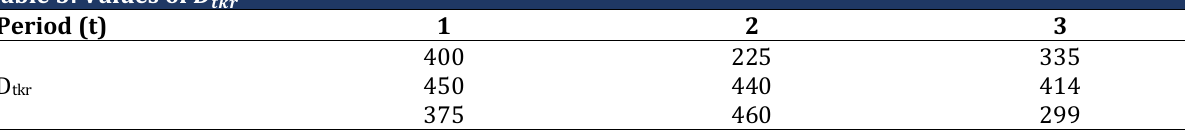
Table 3: Values of 𝑫 Period (t)